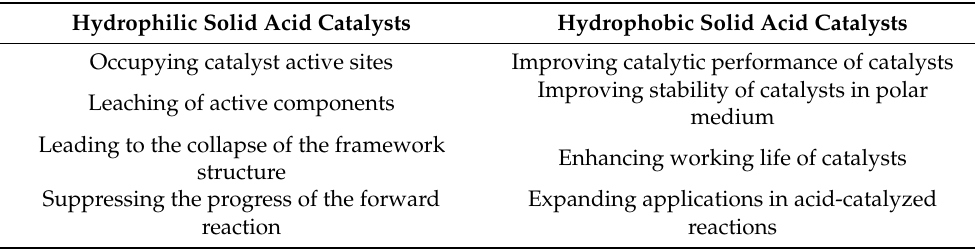
Table 1. Influence of water molecules on hydrophilic solid acid catalysts and the advantages of hydrophobic solid acid